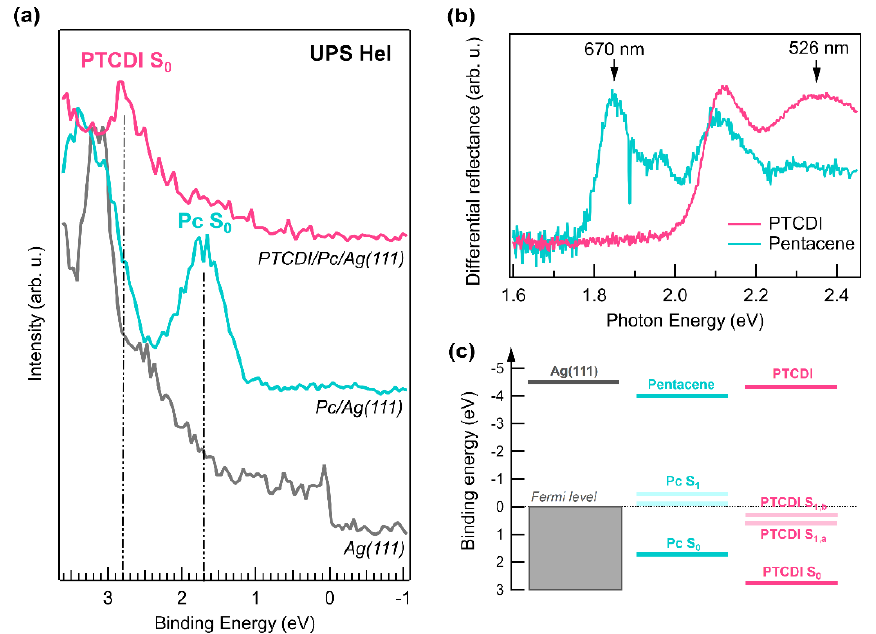
Figure 1. ( a ) UPS (He I) of the clean Ag(111) (gray), of Pc/Ag(111) (cyan), and of PTCDI/Pc/Ag(111) (magenta). The spectra were vertically offset for clarity. The vertical dashed lines identify the Pc S 0 and the PTCDI S 0 positions. ( b ) Optical differential reflectance spectra obtained in situ for thick films of pentacene (cyan) and PTCDI (magenta). ( c ) Scheme of the measured energy level alignment.